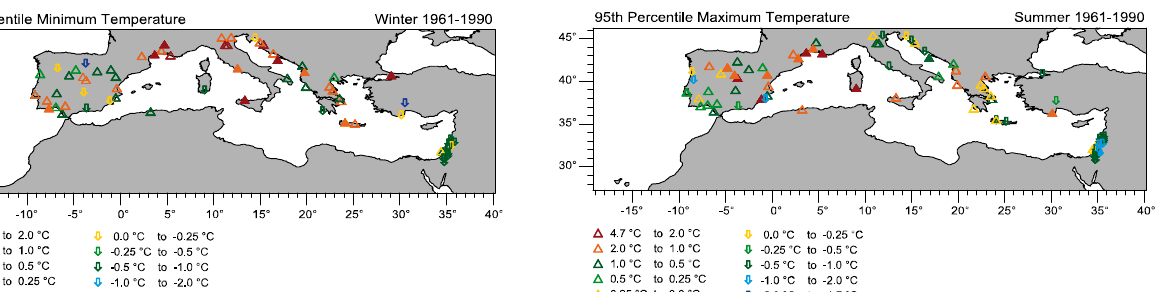
Figure 1: Location of the stations with minimum and maximum temperature data in the Mediterranean area.